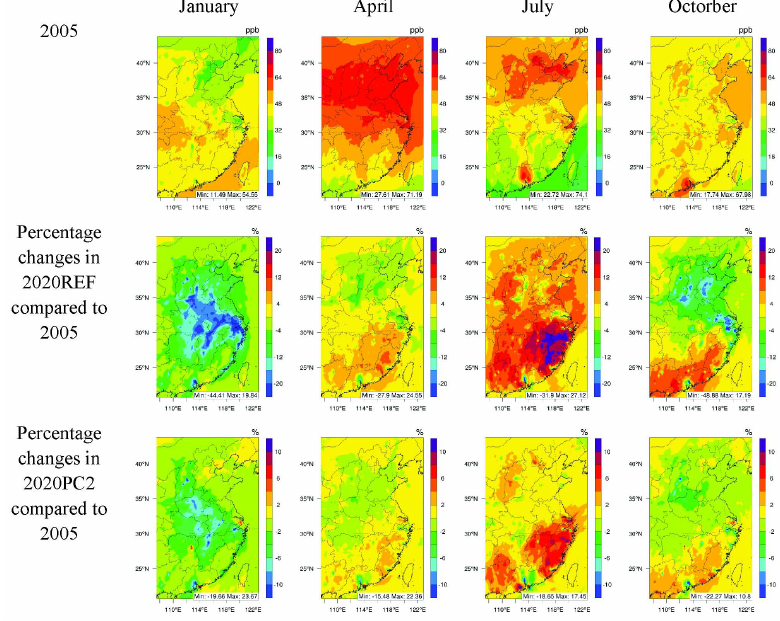
Fig. 6. Spatial changes of O 3 in 2020 (monthly mean of daily 1-h